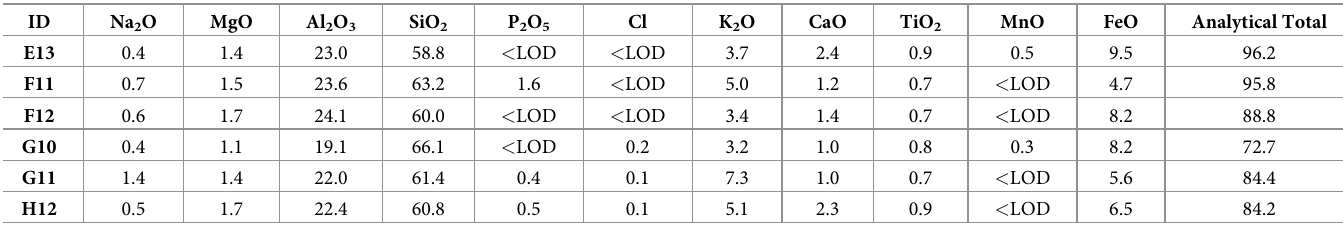
Table 3. SEM-EDS results (wt%) of ceramic matrix analyses.